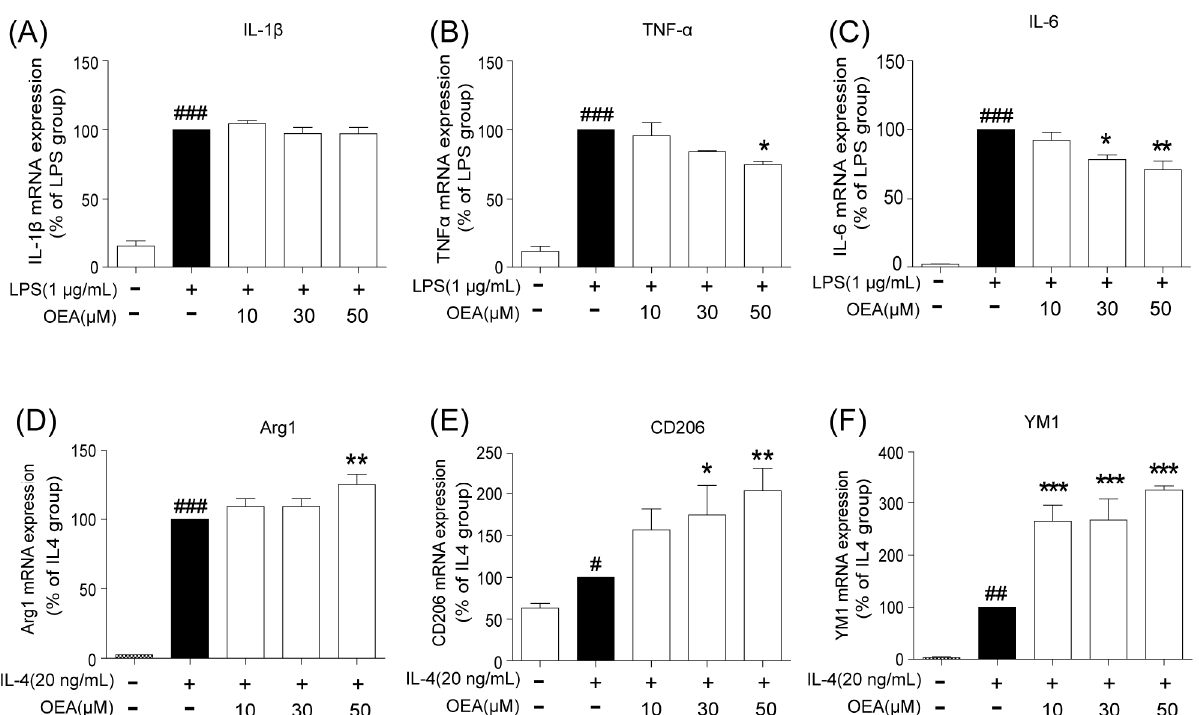
Figure 5. OEA inhibits LPS-induced M1 polarization and further promotes IL-4-induced M2 polar- ization in BV2 microglial cells. BV2 microglia were stimulated with LPS (1 ug/mL) or L4 (20 ng/mL) and then treated with vehicle or 10, 30 and 50 µM OEA. ( A – C ) The mRNA expression of M1 markers was examined by RT-PCR. ( D – F ) The mRNA expression of M2 markers was examined by RT-PCR. Samples were collected from five independent experiments, each performed in duplicate. The data are the means ± SEM. n = 5 per group. # p < 0.05, ## p < 0.01, ### p < 0.001 vs. the control (CON) group; * p < 0.05, ** p < 0.01, *** p < 0.001 vs. LPS-induced or IL-4-inuced group.